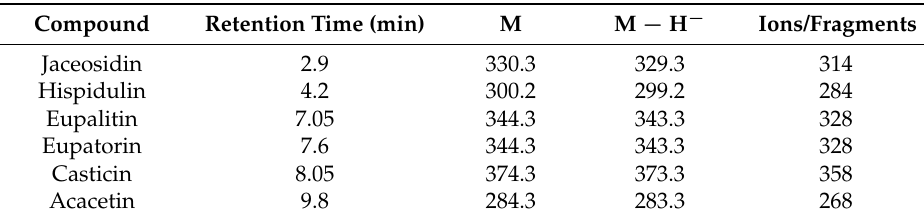
Table 10. Retention times (RT) and specific ions of the tested methoxylated flavones.